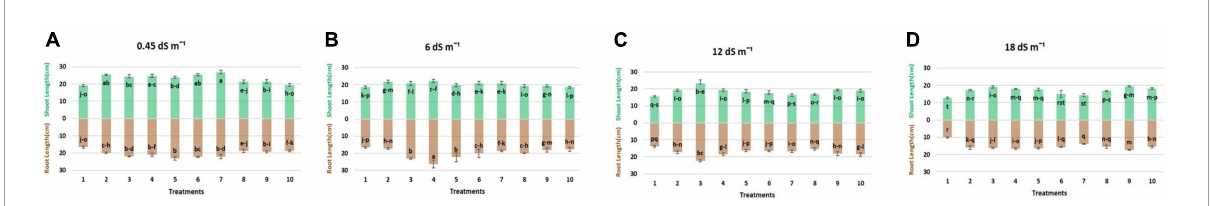
FIGURE2 Effect of multi-strains inoculum on shoot length (cm plant − 1 ) and root length (cm plant − 1 ) of wheat in the presence of salinity under the axenic condition. (A–D) Different levels of salinity.